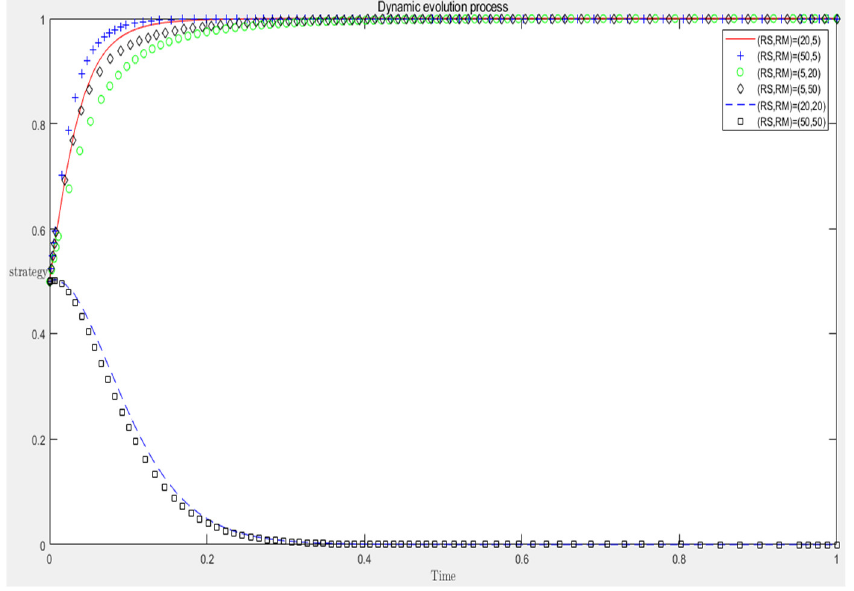
Figure 8. Influence of consumer feedback.